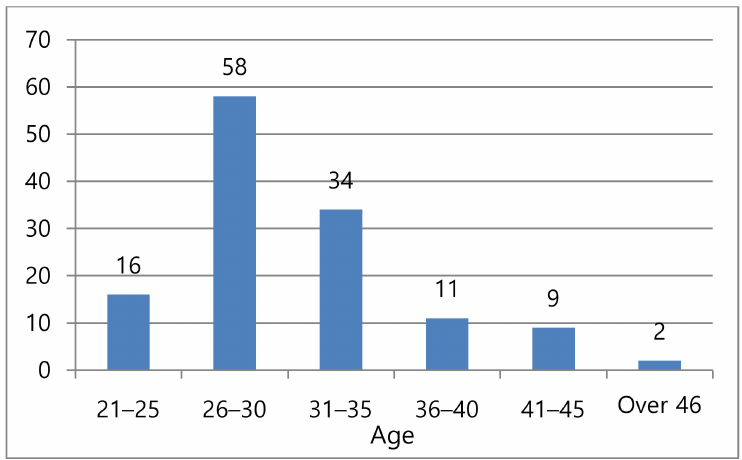
Figure 3. Age of the research